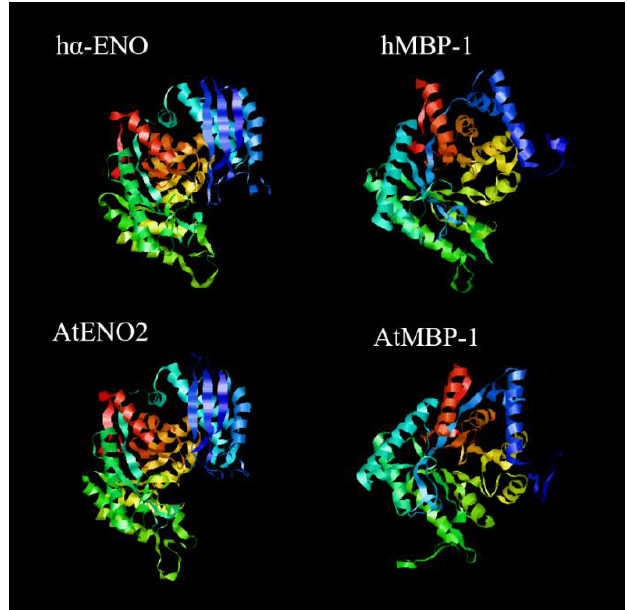
Figure 2. Predicted model of human α -ENO and MBP- 1 (hα -ENO and hMBP-1) and Arabidopsis thaliana ENO2 and MBP-1 (AtENO2 and AtMBP-1). Blue marks N-terminus and red marks C-terminus. Other colors represent the different domains.